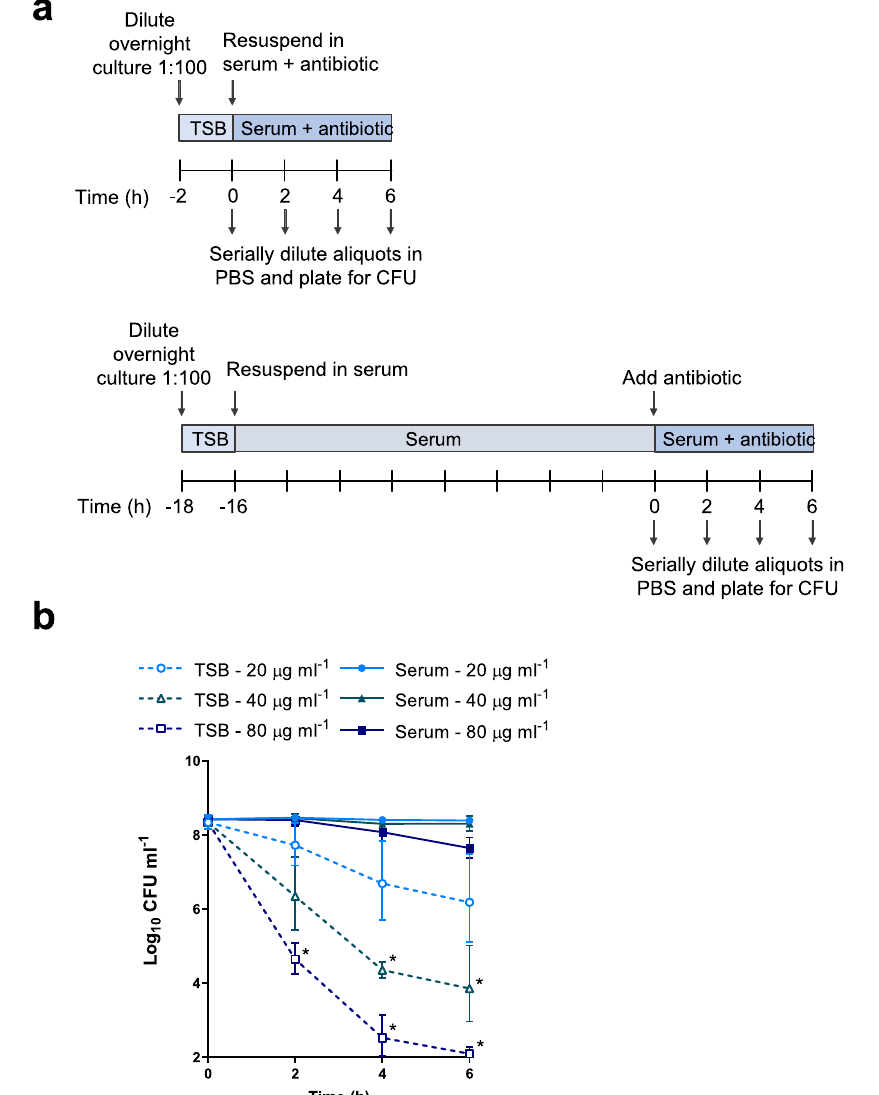
Fig. 1 Incubation of S. aureus in serum results in tolerance towards daptomycin. Schematic outlining the protocol used to investigate the susceptibility of TSB-grown and serum-adapted cultures of S. aureus to daptomycin ( a ). Log 10 CFU ml − 1 of TSB-grown and serum-adapted cultures of S. aureus USA300 WT over 6 h incubation in serum with 20 – 80 µ g ml − 1 daptomycin ( b ). Graph represents the geometric mean ± geometric standard deviation of three independent experiments (* for 40 µ g ml − 1 P = 0.0014 (4 hr), 0.0472 (6 h) and for 80 µ g ml − 1 P = 0.0068 (2 h), 0.0042 (4 h), 0.0003 (6 h) determined by two-way ANOVA with Tukey ’ s post-hoc test, TSB-grown compared to serum-adapted at each time-point and dose). TSB, tryptic soy broth; PBS, phosphate-buffered saline; CFU, colony-forming units. Source data are provided as a Source Data fi